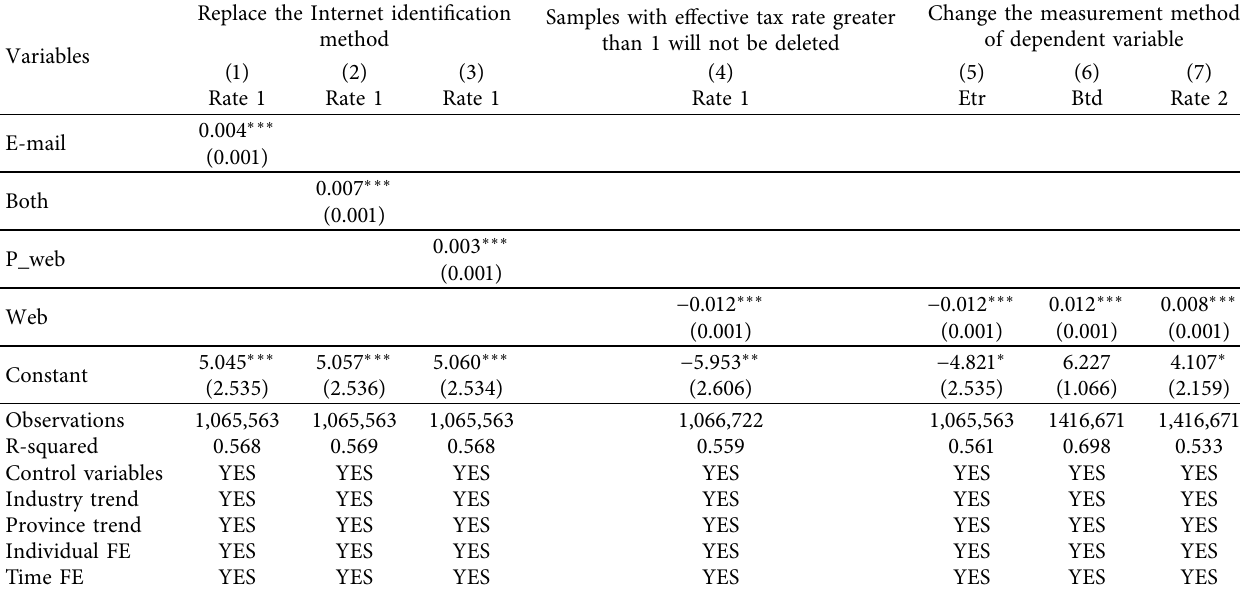
Table 6: Robustness